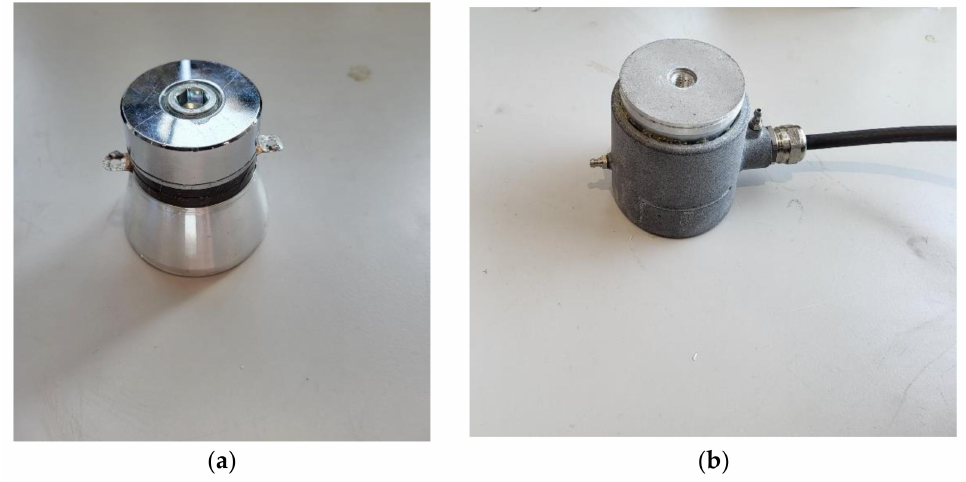
Figure 2. Transducers used in tests: ( a ) plain and ( b ) marinised transducer.